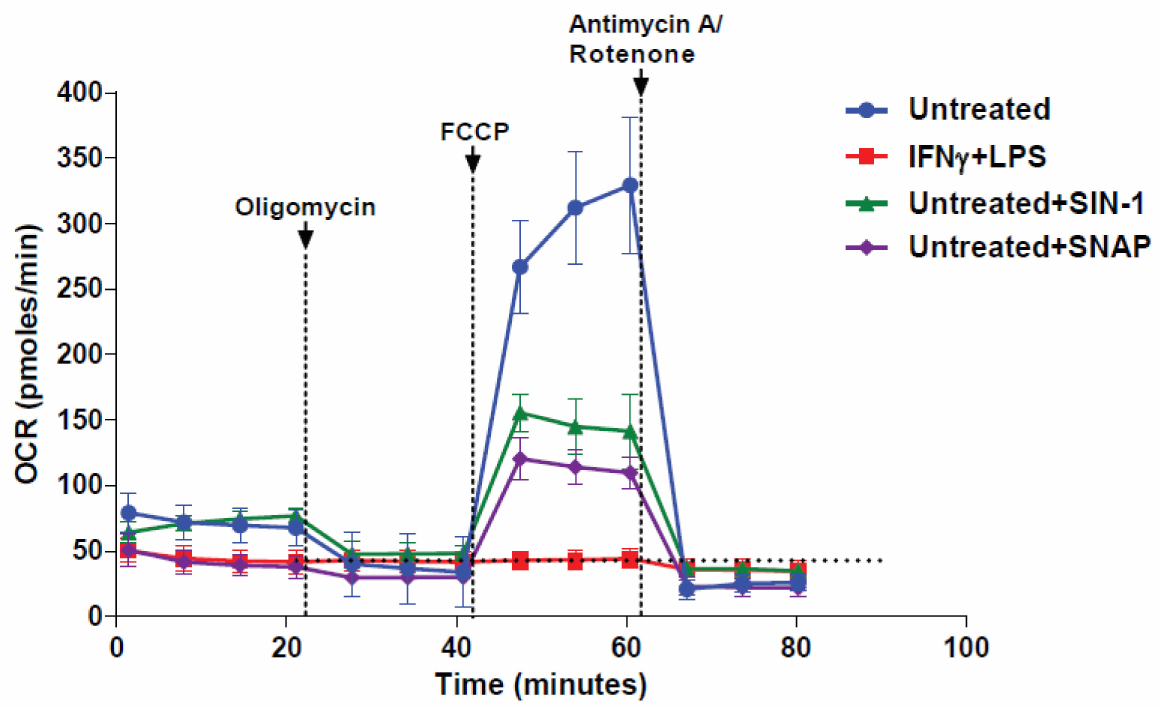
Figure 3. NO • and O 2 •− donors inhibit the respiration of naïve macrophages. Macrophages were activated for 24 h with the IFN γ + LPS (40 ng/mL and 10 ng/mL respectively) or not (untreated) and subjected to serial injections of oligomycin (2 µ M), FCCP (1 µ M) and antimycin A/rotentone (2/2 µ M), according to the mitostress protocol. A Seahorse XFe96 metabolic analyzer was used to record the changes in the oxygen consumption rate (OCR). The reactive species-donors SIN-1 (NO • and O 2 •− ) or SNAP (NO • ) were added (3 mM for either) to untreated (naïve) macrophages prior to the assay. For comparison reasons horizontal intermittent line indicate the basal OCR levels of IFN γ + LPS activated macrophages. The vertical intermittent lines indicate the injection points. One representative experiment is shown, with data presented as mean ± STD of at least three replicates per